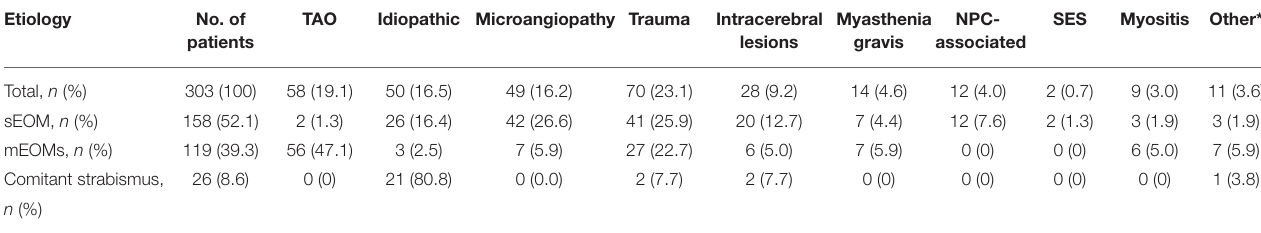
TABLE 1 | Classification and etiologies of patients with diplopia. Etiology